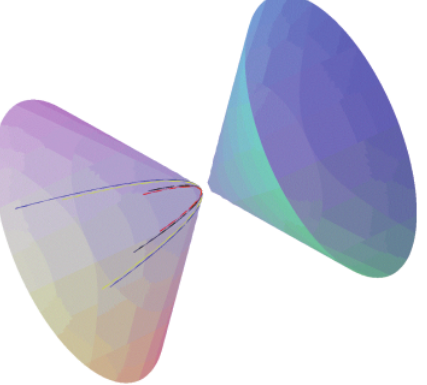
Figure 5: Pseudohyperbolical Smarandache curves of 𝛼 and the curve 𝛼 on 𝐻 2 0 (1)